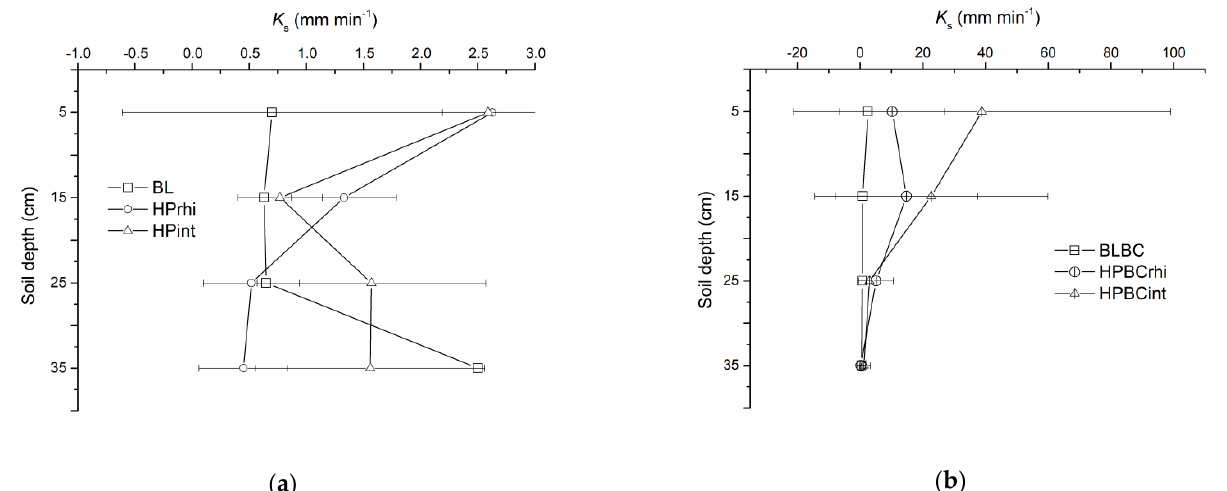
Figure 5. ( a ) Mean values and standard deviations of saturated soil hydraulic conductivity ( K s ) for BL, HPrhi and HPint; ( b ) Mean values and standard deviations of saturated soil hydraulic conductivity ( K s ) for BLBC, HPBCrhi and HPBCint. Note: BL—bare land treatment; HPrhi—planted location in honeysuckle planting treatment; HPint—inter-row location in honeysuckle planting